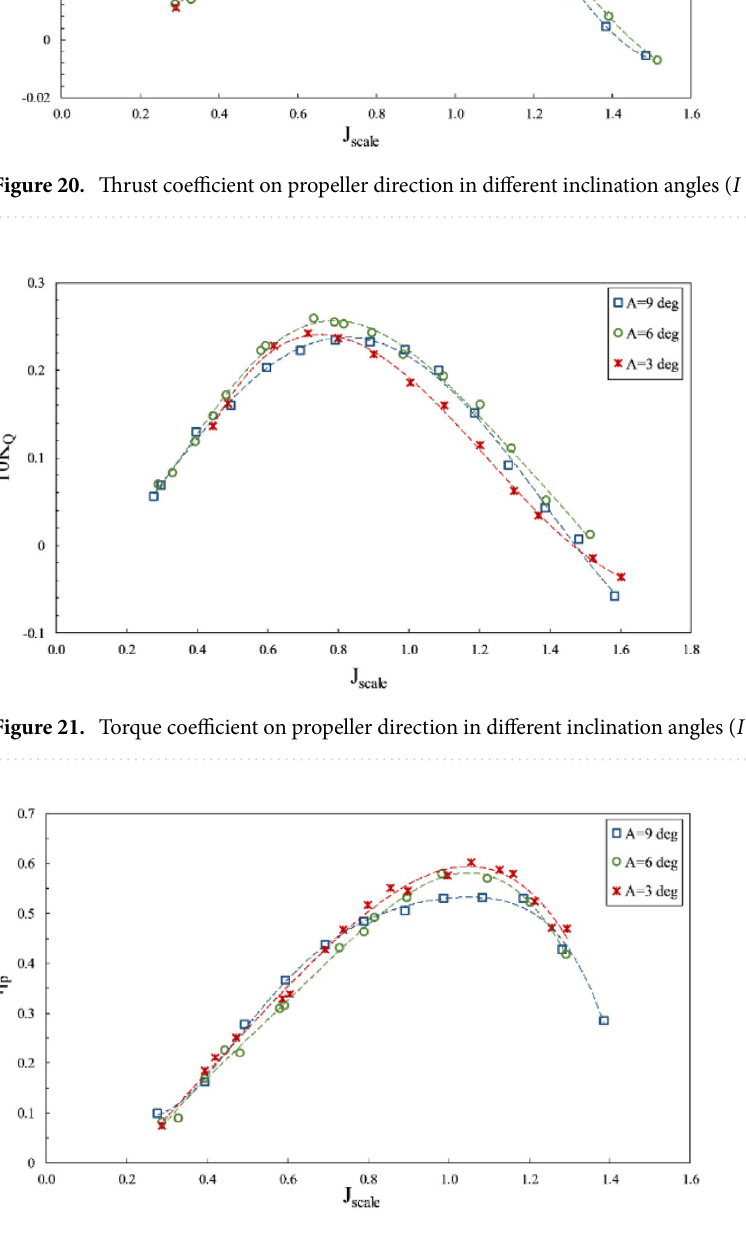
Figure 22. Efficiency on propeller direction in different inclination angles ( I = 0.4